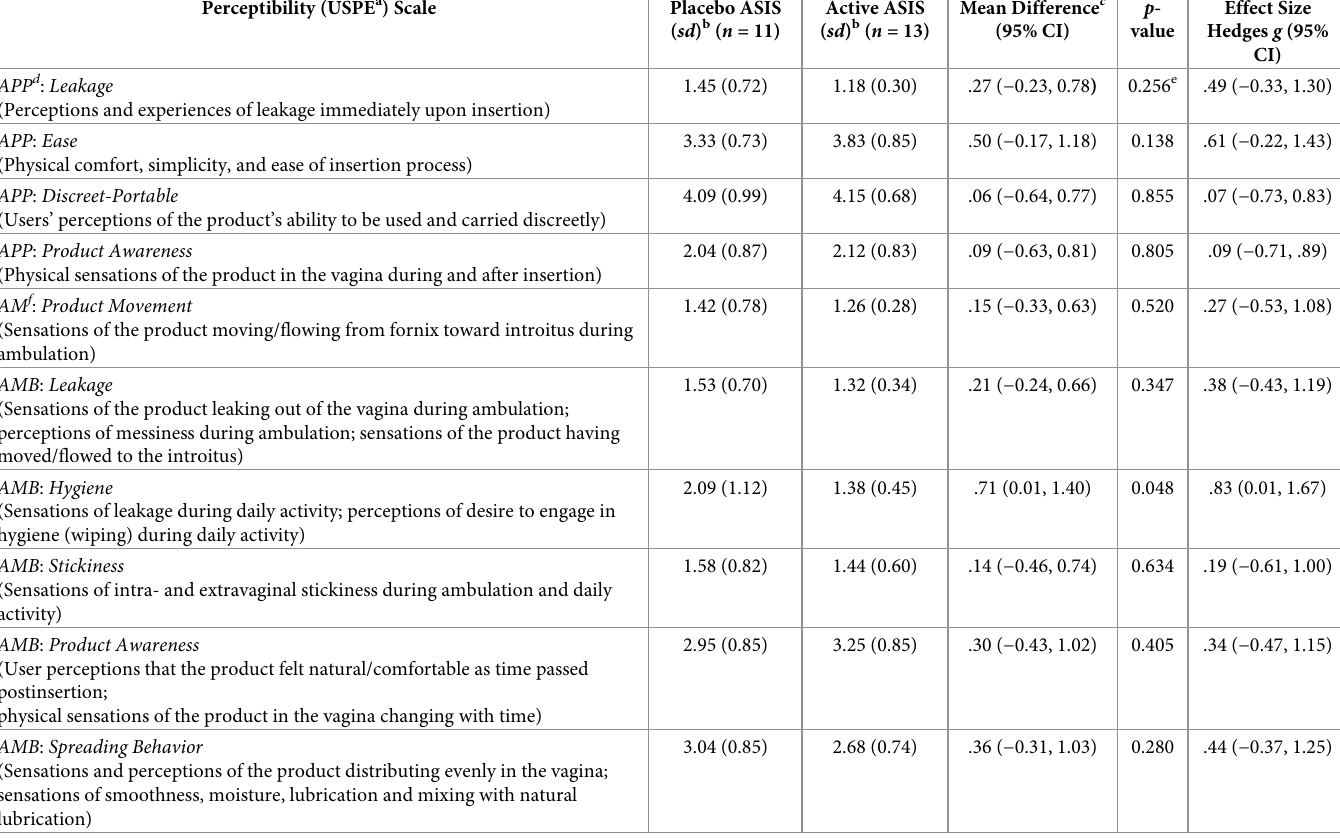
Table 3. Group comparisons with averaged scale item scores, standard deviations, mean differences, confidence intervals, and effect sizes for application (APP) and ambulation (AMB) scales removing nonevaluable cases. Perceptibility (USPE a )